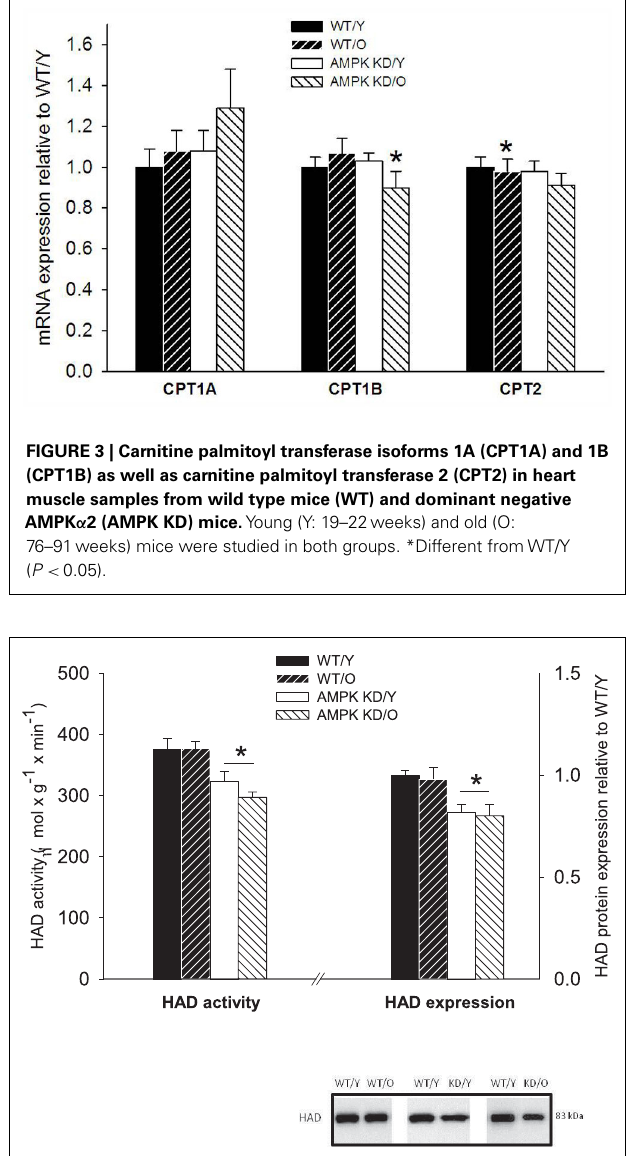
and 0.71 ± 0.04, P < 0.05 in old AMPK α 2-KD compared to WT/Y ( Figure4 ).Therewasnosignificantage-effectonHADexpression, indicative of sustained β -oxidative capacity irrespective of old